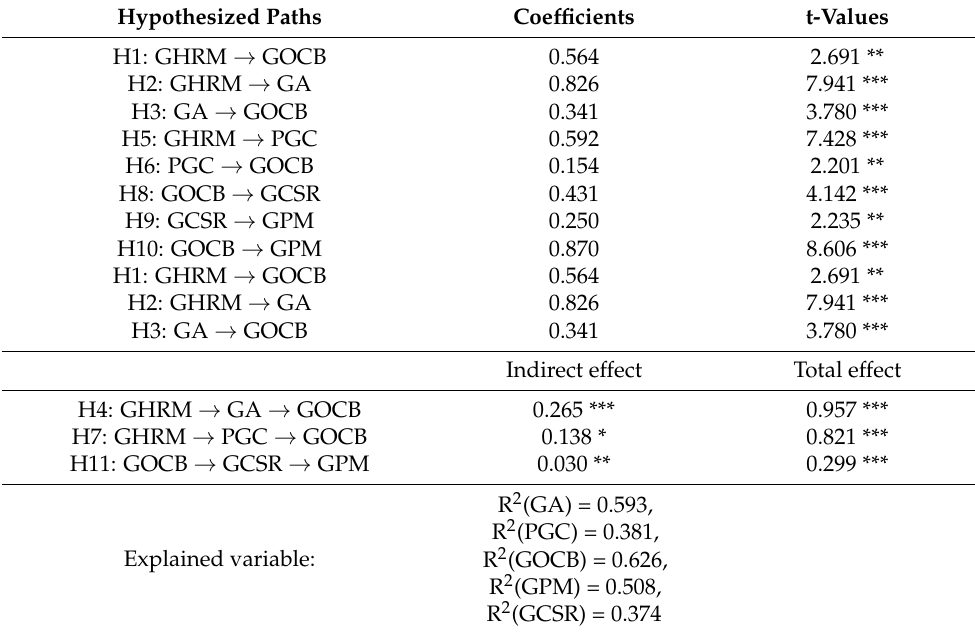
Table 2. Hypothesis